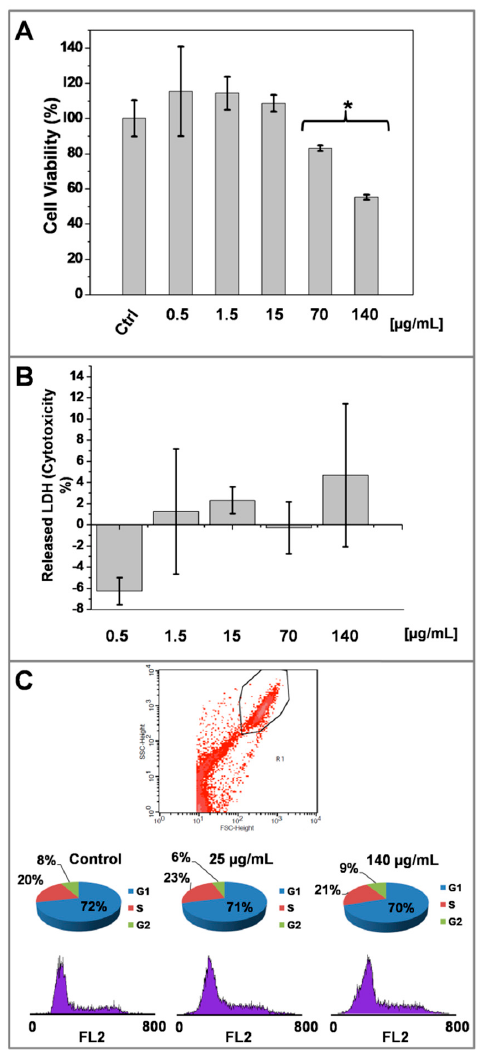
Figure 6. Effect of AgNP@R6G@BSA on A431 human epidermoid carcinoma cell line biocompatibility. Mitochondrial function (MTT reduction) after 24 h of treatment with increasing concentrations of AgNPs ( A ). Lactate dehydrogenase release assay (LDH) after 24 h of treatment with increasing concentrations of AgNP@R6G@BSA ( B ). Flow cytometry analysis of cell cycle after 24 h of treatment with increasing concentrations of AgNP@R6G@BSA ( C ). Data represented the mean ± SD. Measurements were made in three replicas for each experimental